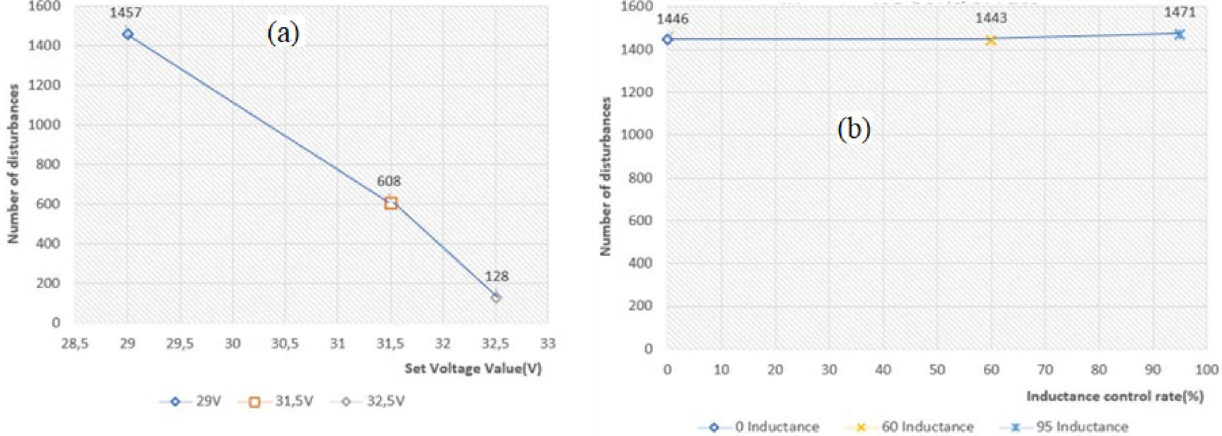
Fig. 9 Graphical representation of voltage disturbances vs set voltage values and inductance control rate: a , Number of voltage distur- bances Vs Set Voltage vaue; b , number of Voltage disturbances Vs set inductance control